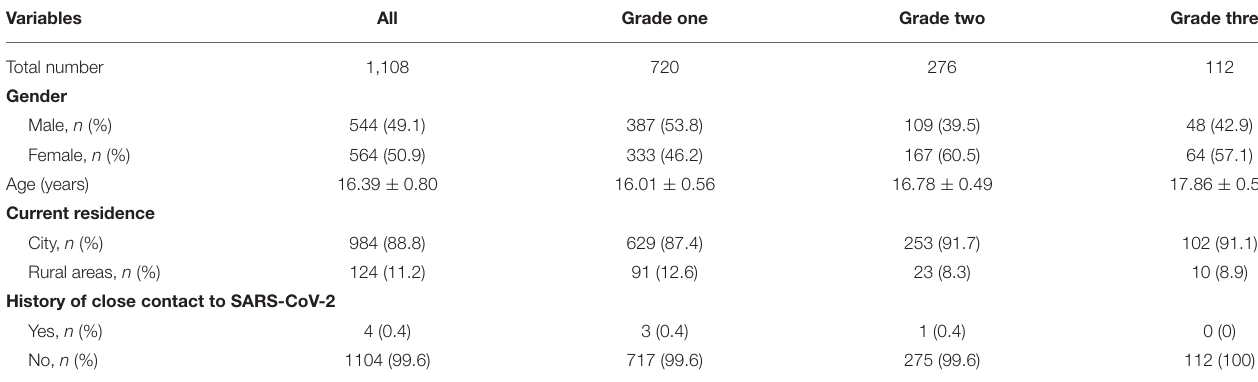
TABLE 1 | Demographic characteristics of the sample.